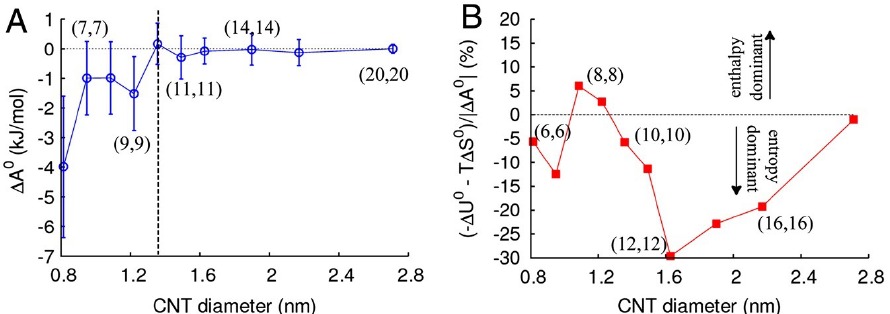
Figure 3. Relative thermodynamics of water confined in CNTs of infinite length. The CNTs are labeled (n, m) according to their chirality where n = m indicates armchair nanotubes. ( A ) Relative Helmholtz − A 0 free energy ∆ A 0 = A 0 as a function of CNT diameter, referenced to a bulk water box confined bulk of 14,000 molecules: U 0 = − 34.3 ± 0.1 kJ/mol, S 0 = 62.9 ± 0.2 J · mol − 1 · K − 1 , A 0 = − 53.3 ± bulk bulk bulk 0.1 kJ/mol, where U denotes the enthalpy and S the entropy. The error bars indicate the statistical errors. The vertical dashed line indicates the point of convergence to the bulk. ( B ) Percentage of the free energy ∆ A 0 arising from the enthalpy ∆ U 0 ( ∆ U 0 = ∆ U 0 - ∆ U 0 ) or entropy ∆ S 0 ( ∆ S 0 = S 0 - S 0 ). confined bulk confined bulk Reprinted with permission from Ref.